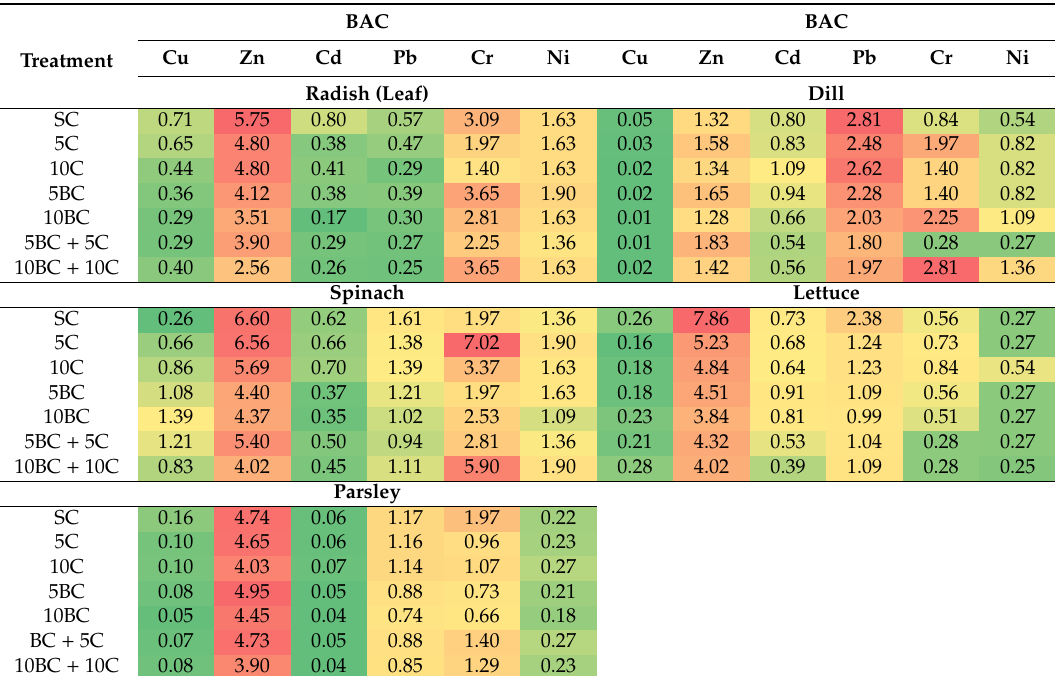
Table 5. Bioaccumulation coe ffi cient (BAC) of Cu, Zn, Cd, Pb, Cr and Ni in five species of green leafy vegetables grown on soil with di ff erent types and ratios of organic amendments (compost, biochar and mix of both